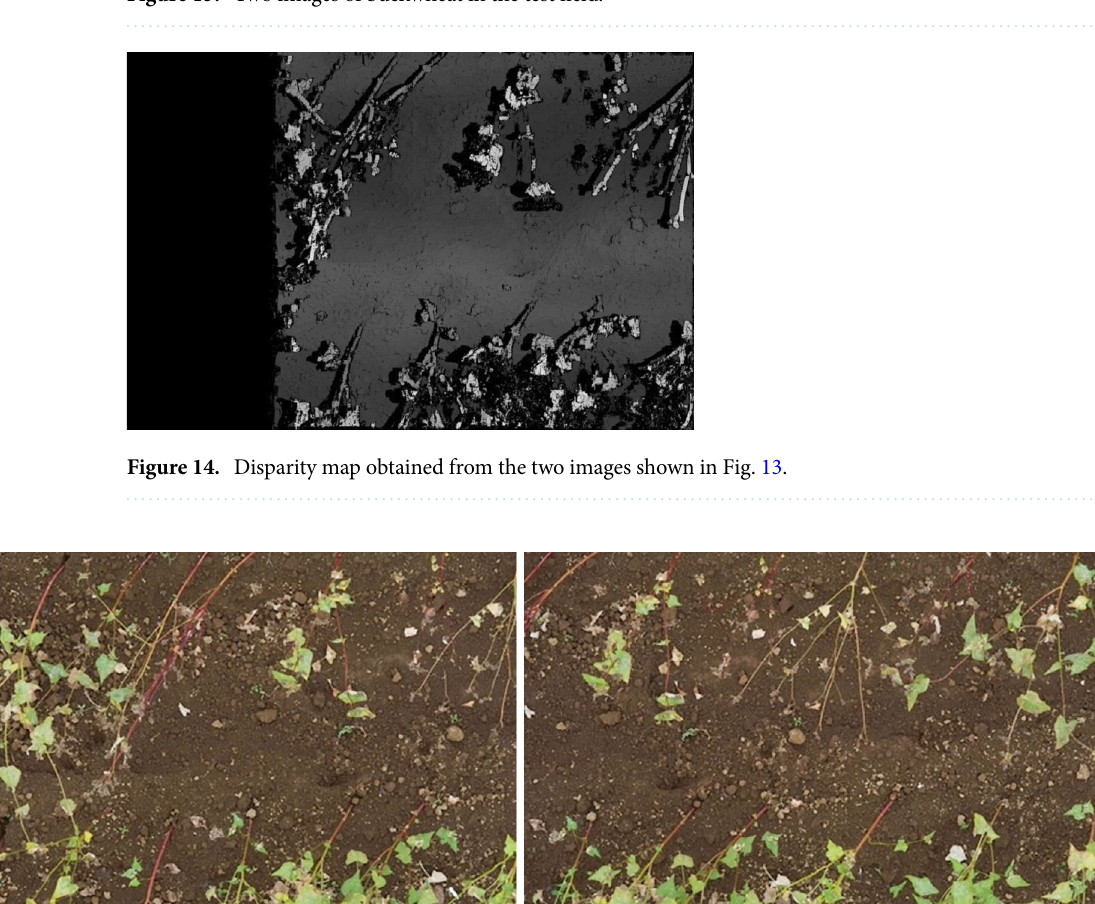
Figure 13. Two images of buckwheat in the test field.